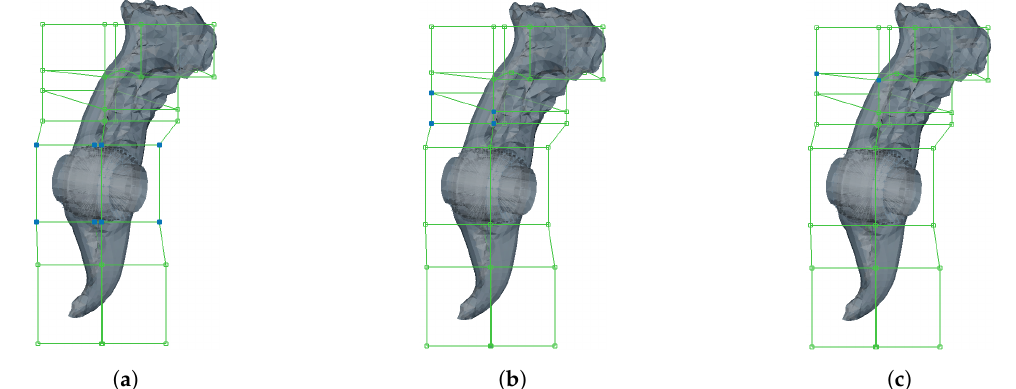
Figure 6. Showcase of morphing structure necessary for displacement and smoothing